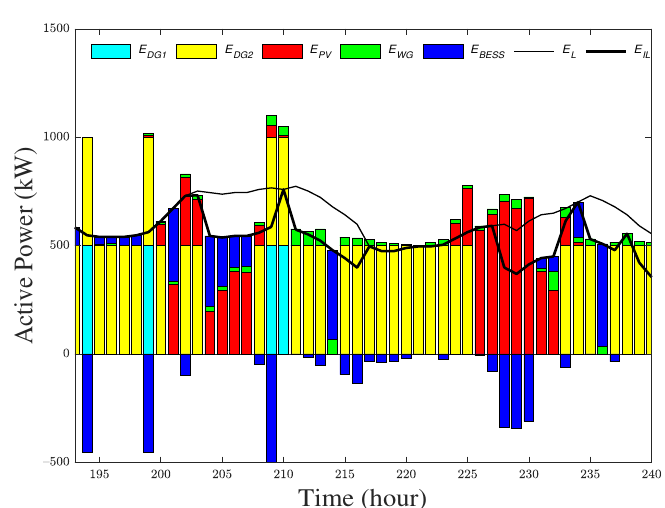
Figure 8. Operation schedule of 2 days (Case